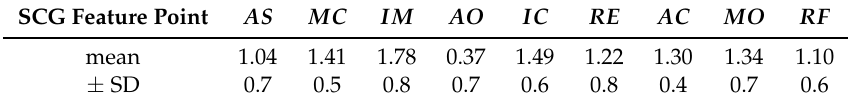
Table 9. The mean error (ms) between automatic and manual SCG feature points’ delineation. SCG Feature Point